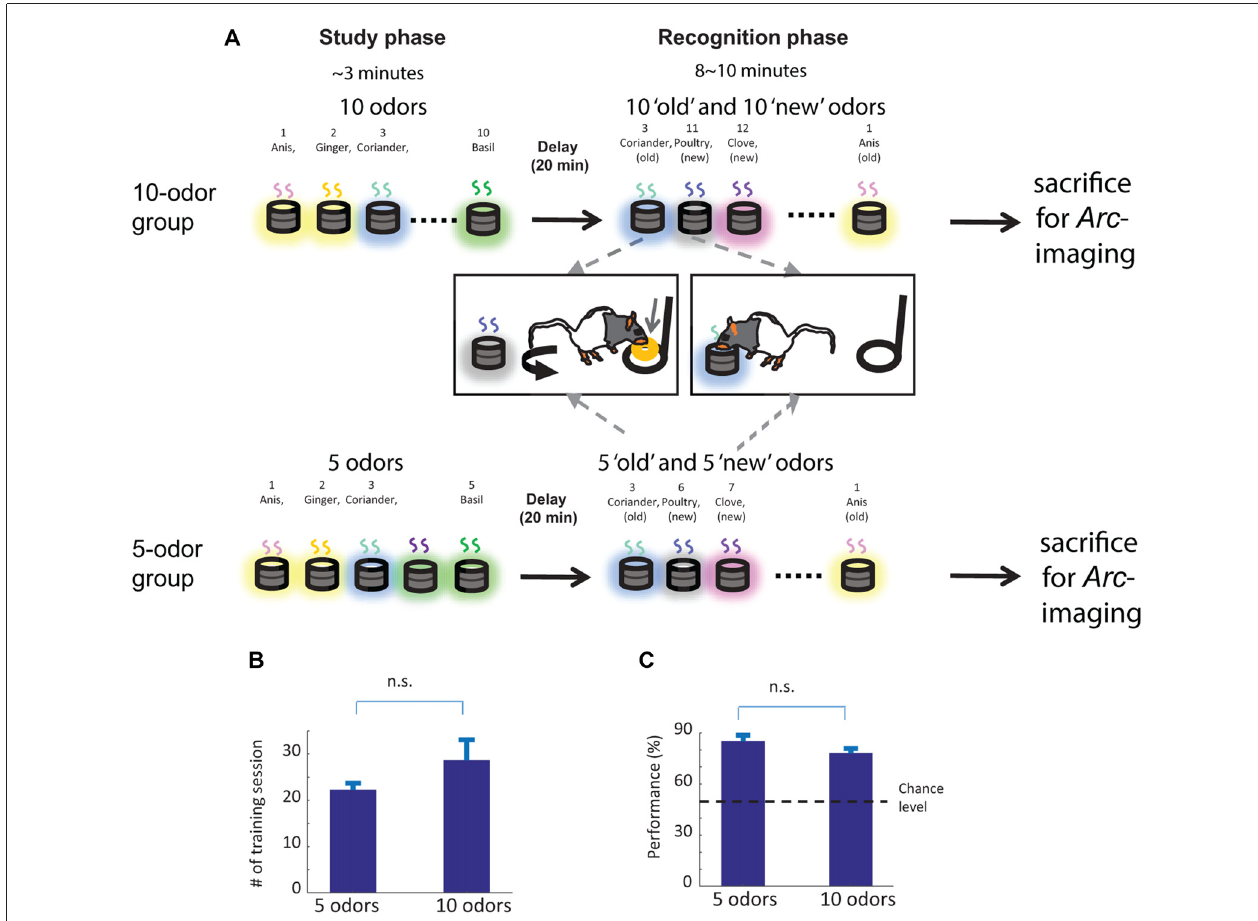
FIGURE 1 | Delayed nonmatch to sample task based on odors, overview of the training scheme and memory performance on sacrifice day. (A) Top: experimental procedure for the 10-odor group. Ten odors were presented sequentially during the study phase. After 20 min delay, the memory for the 10 “old” studied odors was tested by presenting the “old” odors intermixed with 10 (“new”) odors. The testing odors were presented one at a time. To signal an “old” odor animals should repress digging into the test cup and go to the back of the cage to receive a cereal reward, if correct. To signal a “new” odor, animals should in the test cup to retrieve the same type of rewards. Bottom: experimental procedure for the 5-odor group: only the length of the study and the number of test stimuli changes compared to the 10-odor group. The figure is adapted and modified from Figure 1 in Nakamura et al. (2013). (B) The 5 and 10-odor groups learned to discriminate between “old” and “new” odors within a comparable number of sessions. (C) Memory performance on sacrifice day was also comparable between groups. n.s. not significant. Error bar: